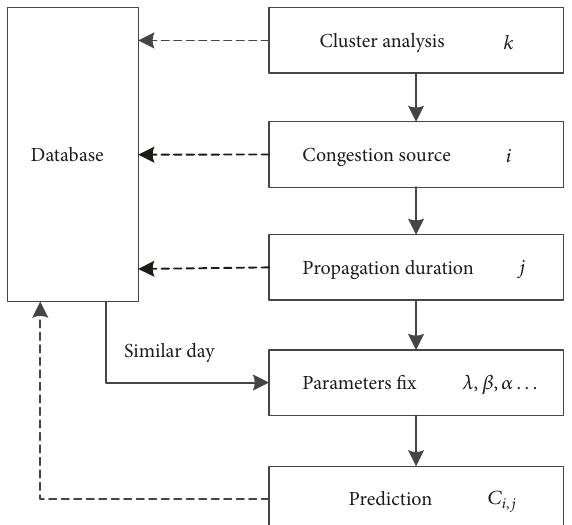
Figure 5: Prediction process of congestion clusters based on heterogeneous network